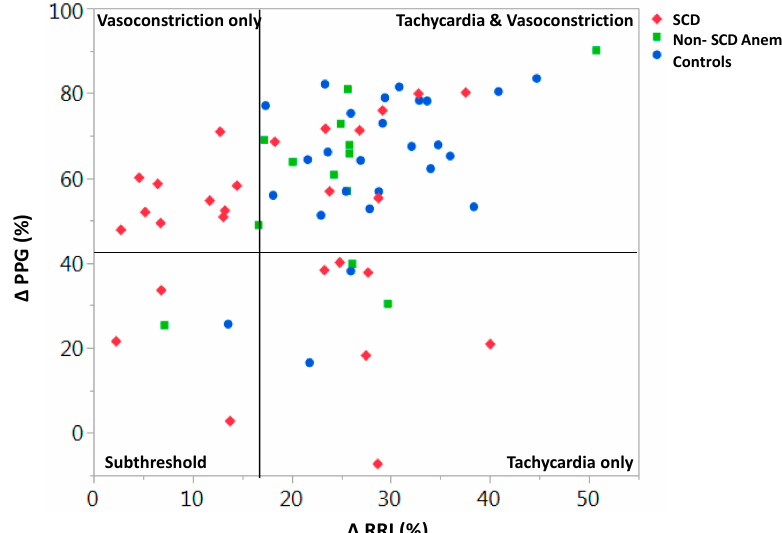
Figure 5. The subjects in the upper-left quadrant have only vasoconstriction in response to head-up-tilt on tilt table testing, in comparison to the normal response of increase in heart rate and vasoconstriction in the upper-right quadrant. The subjects in the vasoconstriction-only group are almost exclusively SCD individuals. Having parasympathetic activity in the lower 10th percentile gives an SCD individual 76% probability of having a vasoconstriction-only phenotype ( p < 0.01). (After [55] with permission).